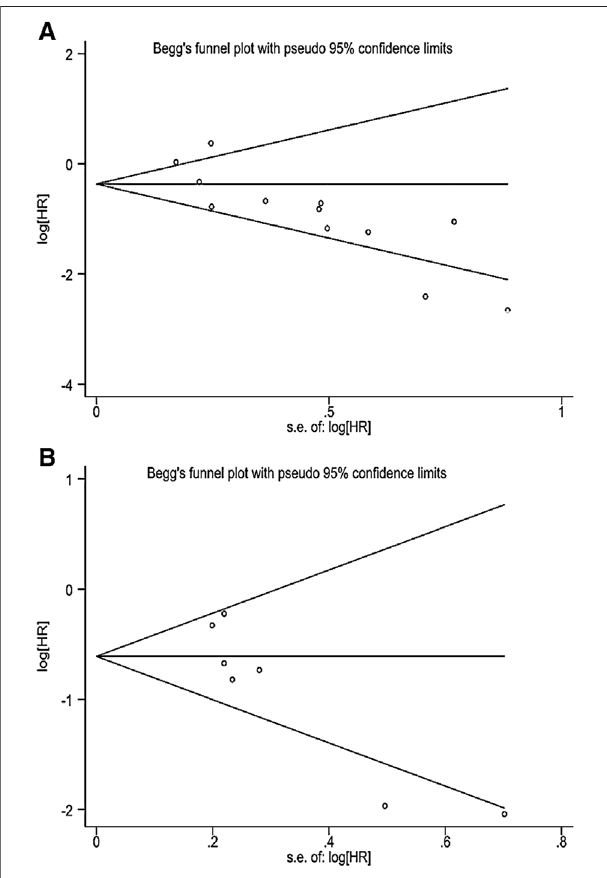
FIGURE5|(A) FilledfunnelplotofcorrelationbetweenTMBandOS. (B) Filled funnel plot of correlation between TMB and